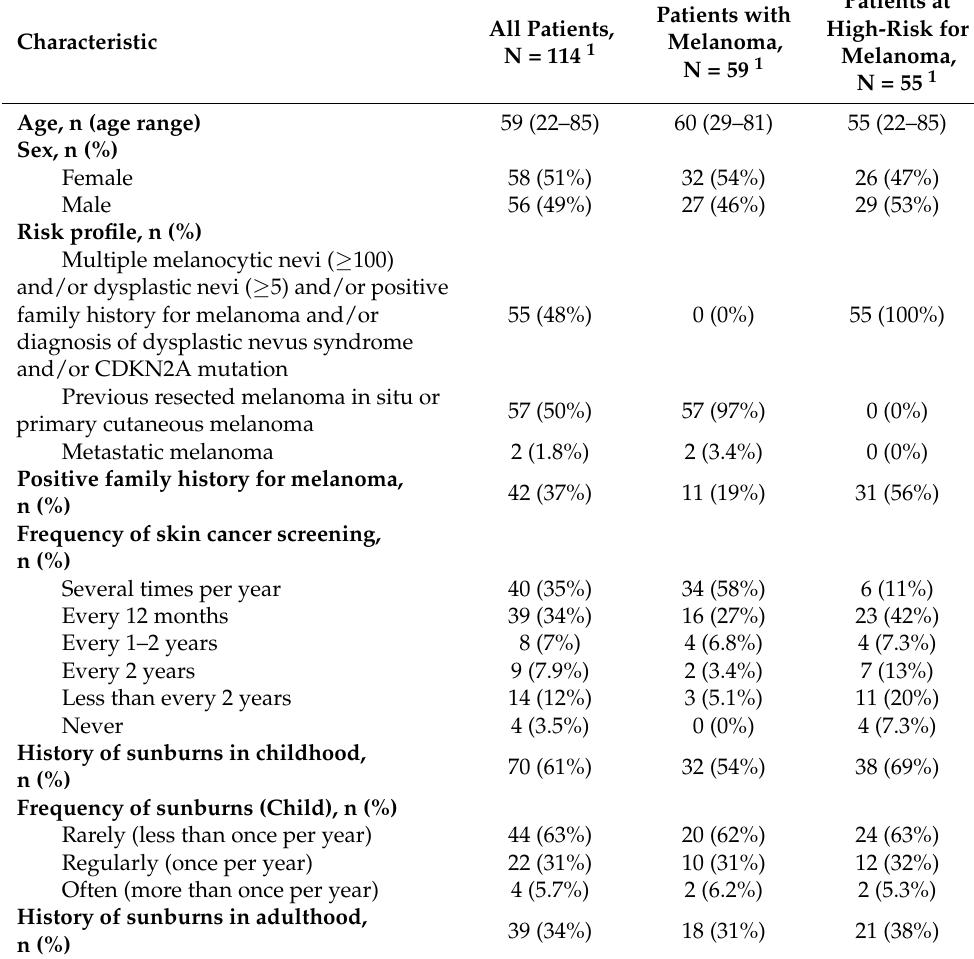
Table 1. Characteristics of the study population and their skin cancer